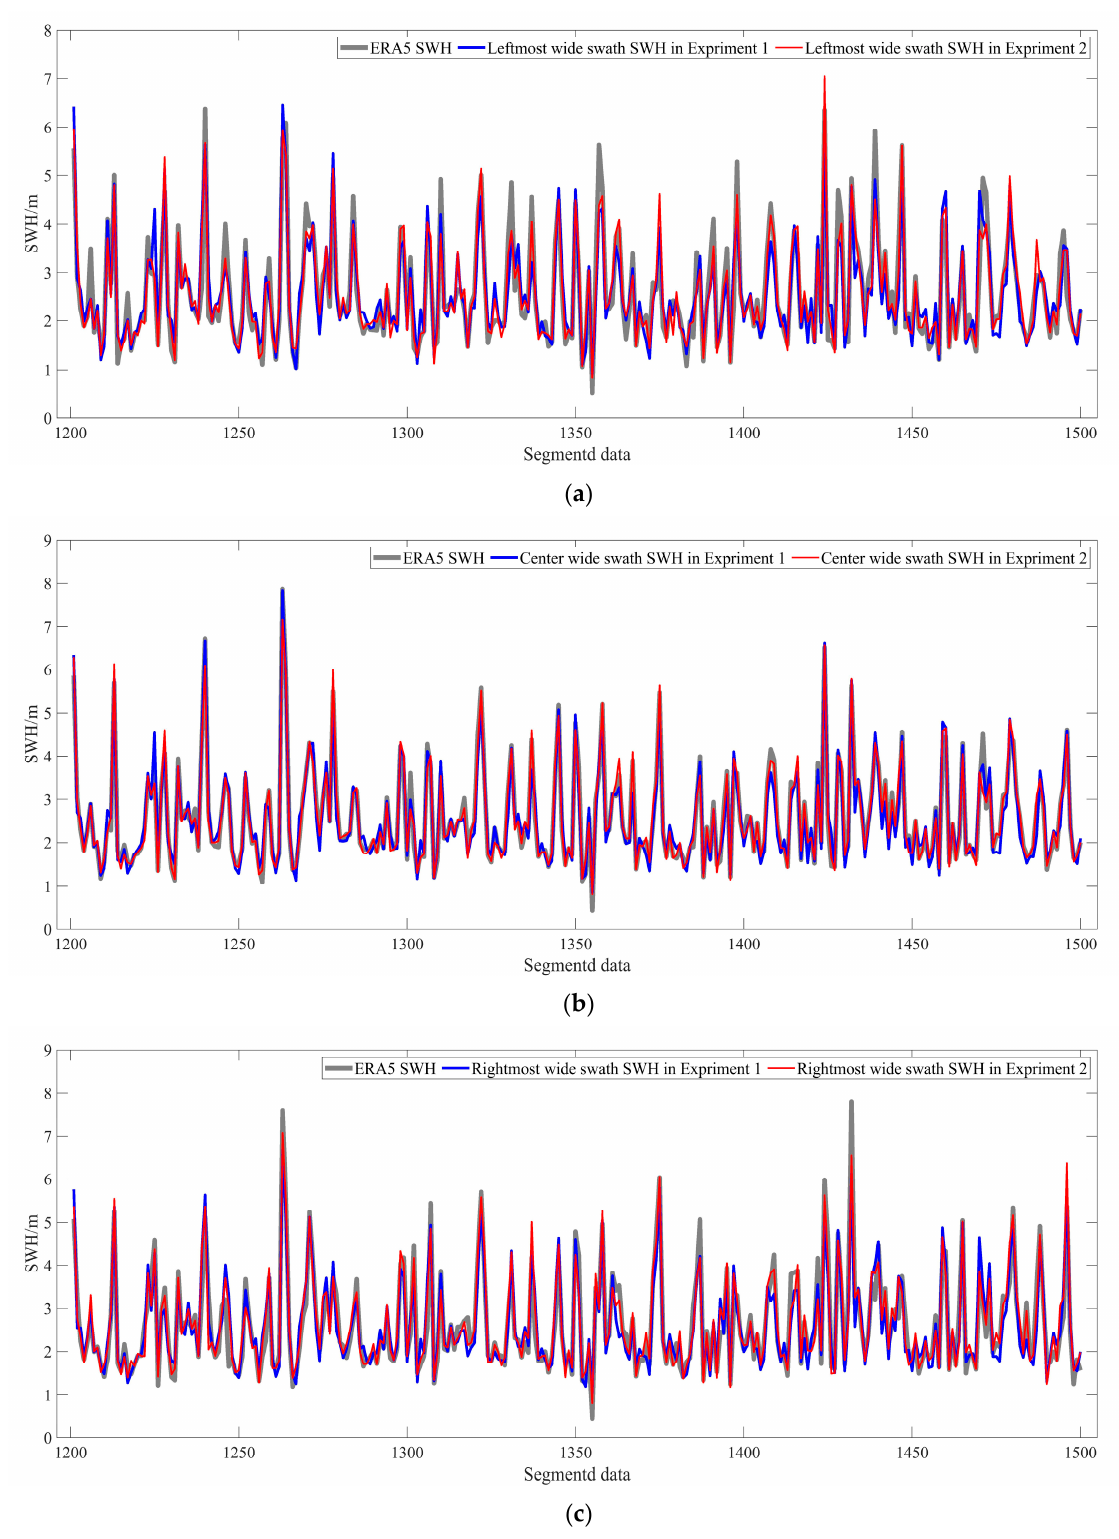
Figure 4. The line graphs for the segmented data. The leftmost, center and rightmost test results of Experiments 1 (blue lines) and 2 (red lines) are denoted in ( a – c ), respectively.